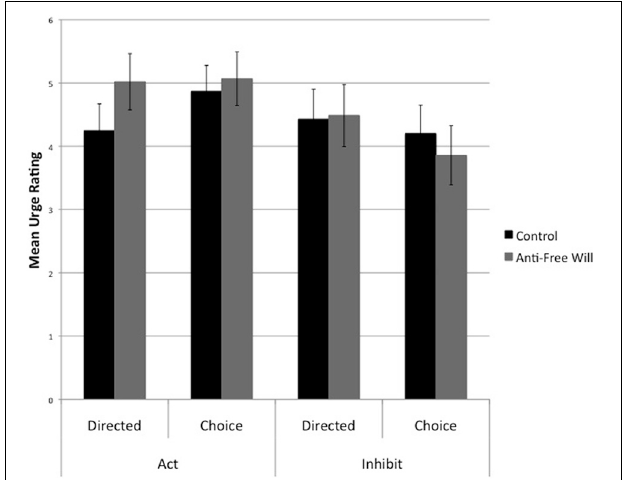
FIGURE 5 | Urge ratings as a function of Instruction (Choice vs. Directed) and Belief condition (Control vs. Anti-free will). Note: values depicted are means and standard